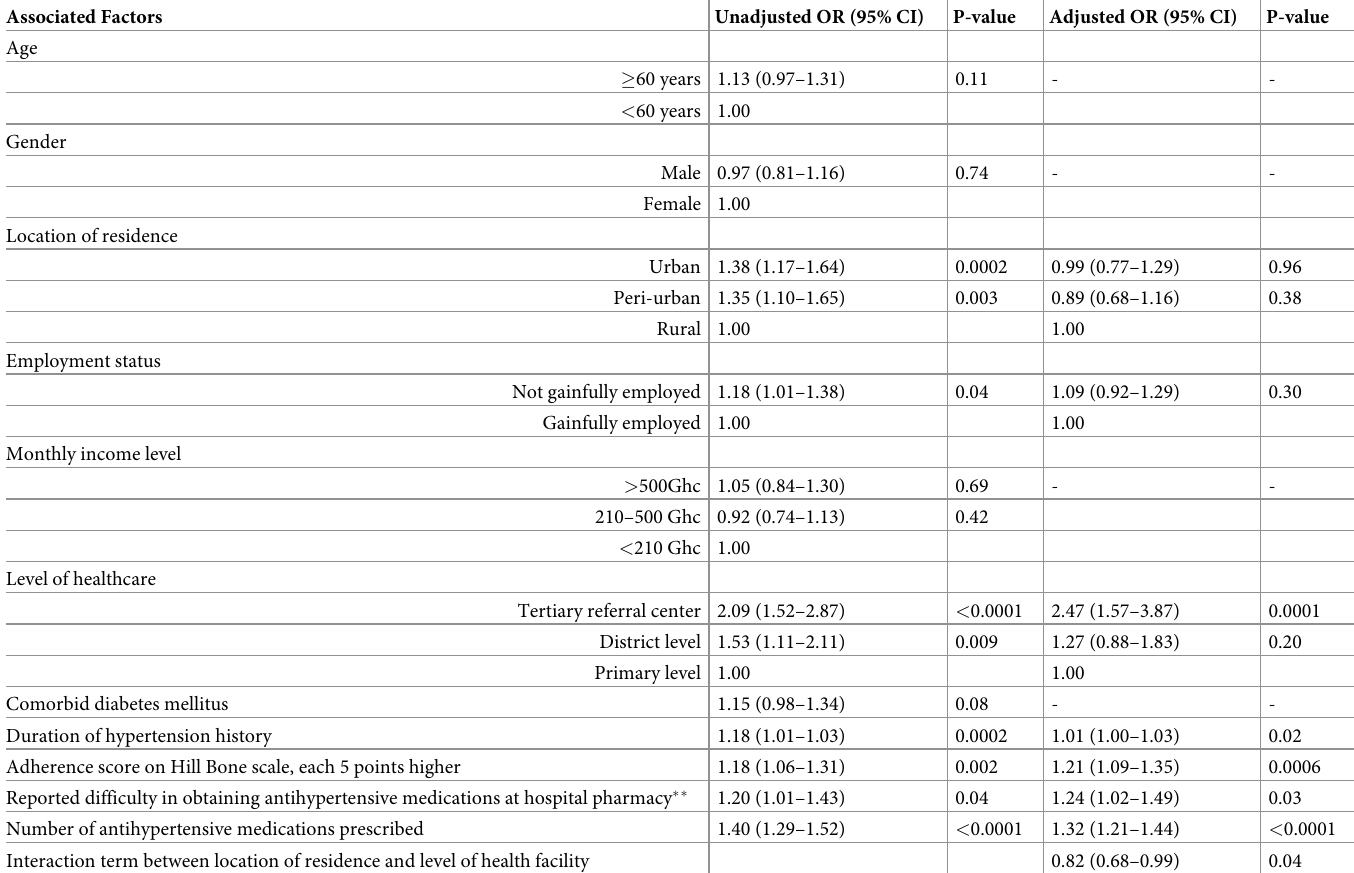
Table 6. Factors associated with suboptimal blood pressure among